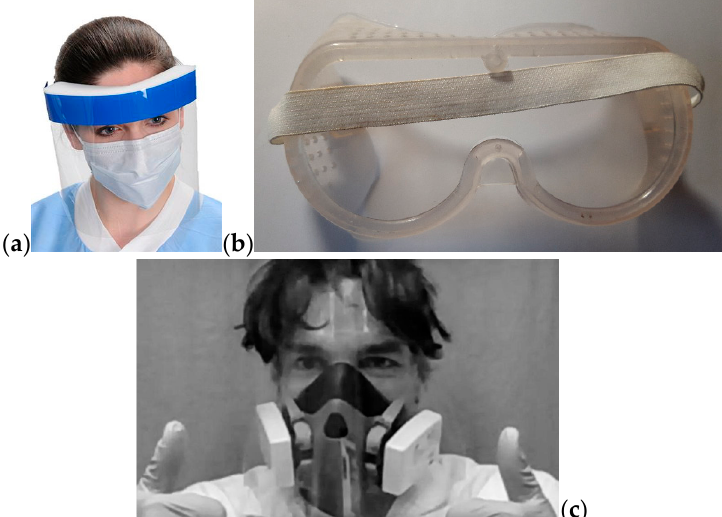
Figure 1. Example of personal protection equipment: ( a ) full face shield (Medical Supplies and Equipment Co., Katy, Texas 77450, USA); ( b ) construction worker goggles Archimedes 91,862 (Technoplast Ltd., St. Petersburg, Russia); ( c ) full face shield (FabLab, Skolkovo Institute of Science and Technology, Moscow, Russia)—near to invisible.